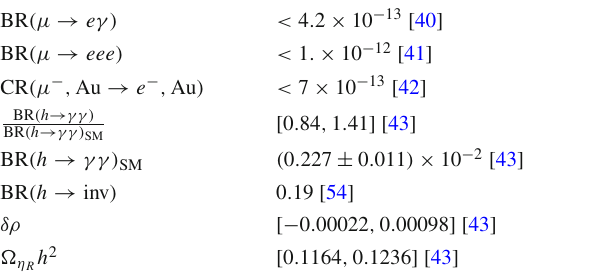
Table 3 List of experimental constraints applied to the numerical